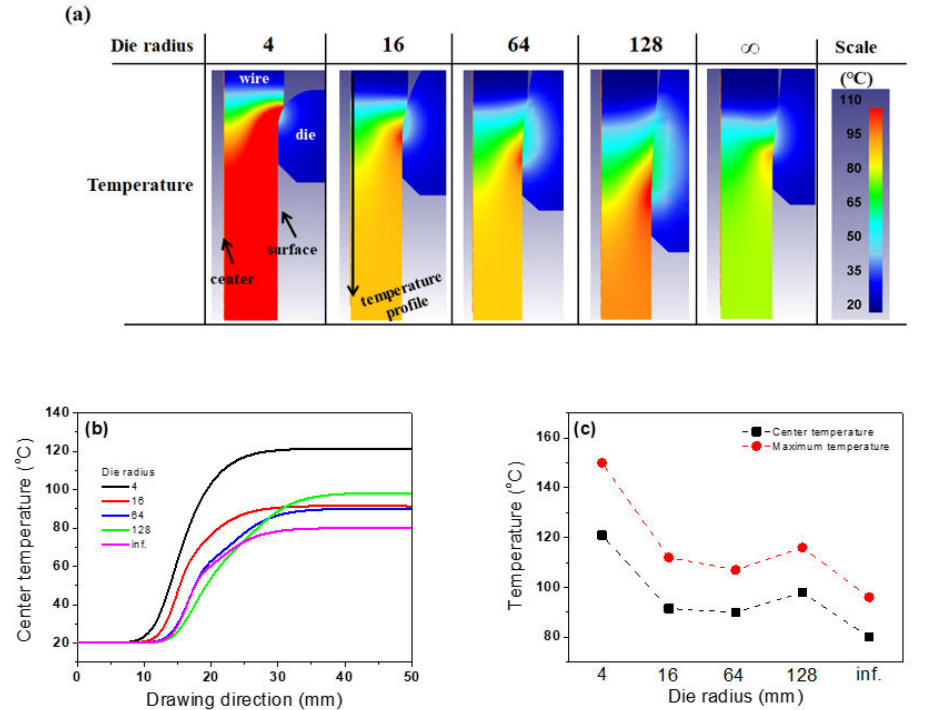
Figure 10. Comparison of ( a ) temperature contour, ( b ) history of center temperature along the drawing direction, and ( c ) the steady-state center temperature and the maximum temperature of the wire with the die